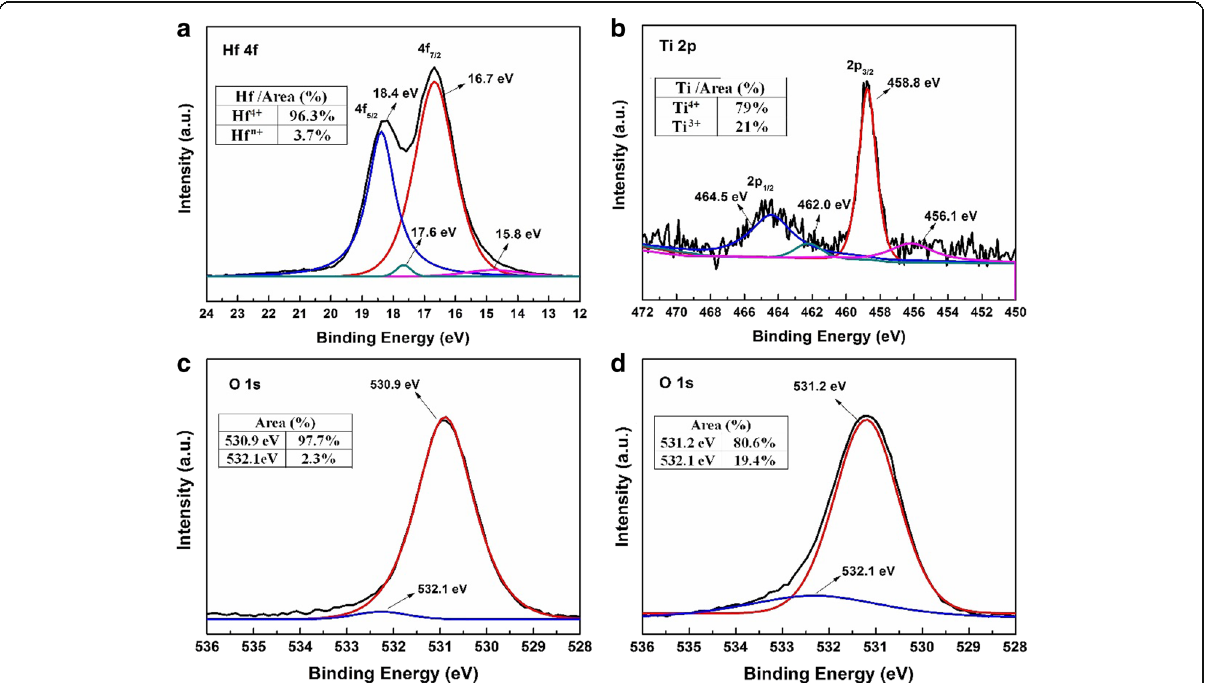
Fig. 6 Narrow-scan XPS spectra from trilayer-structure of HfO 2 /TiO 2 /HfO 2 on TiN-coated Si. a Hf 4f, b Ti 2 p peaks of HfO 2 /TiO 2 /HfO 2. O 1 s peaks of c HfO 2 and d TiO 2